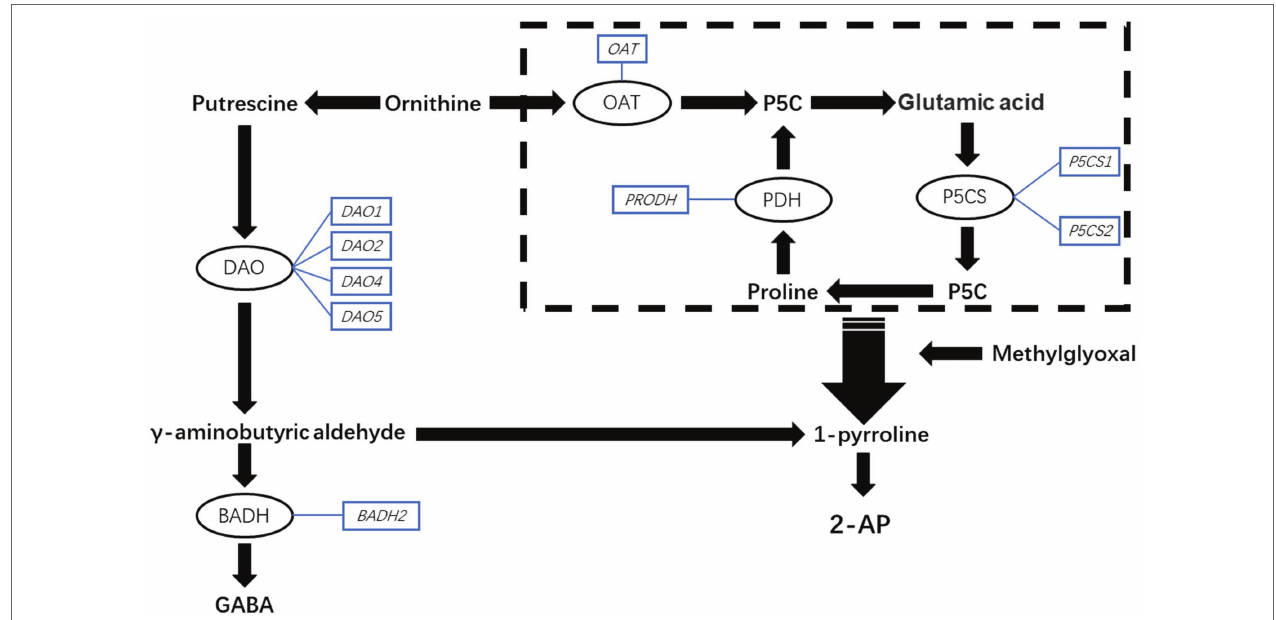
FIGURE 1 | The schematic representation of the potential pathway of 2-AP biosynthesis in fragrant rice. GABA, γ -aminobutyric acid; P5CS, 1-pyrroline-5- carboxylate synthetase; PDH, proline dehydrogenase; OAT, ornithine transaminase; BADH, betaine aldehyde dehydrogenase; DAO, diamine oxidase; P5C, pyrroline- 5-carboxylic